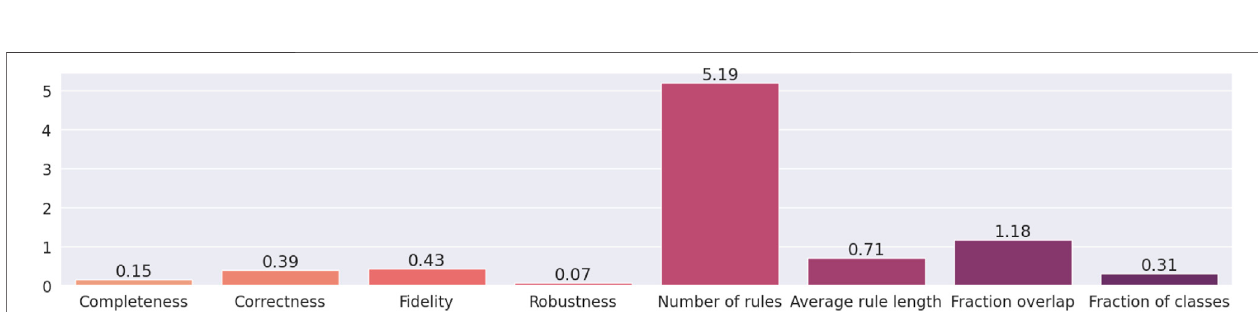
FIGURE 8 | Example of ruleset automatically generated by a rule-extraction method. In this case, the ruleset was created by RxNCM from the Chess dataset.